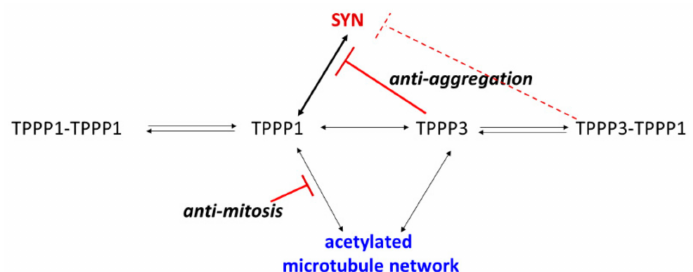
Figure 10. The physiological and pathological interactions of TPPP1 and